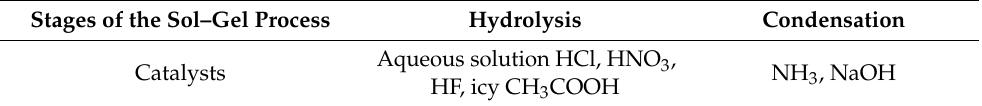
Table 2. Substances accelerating the sol–gel